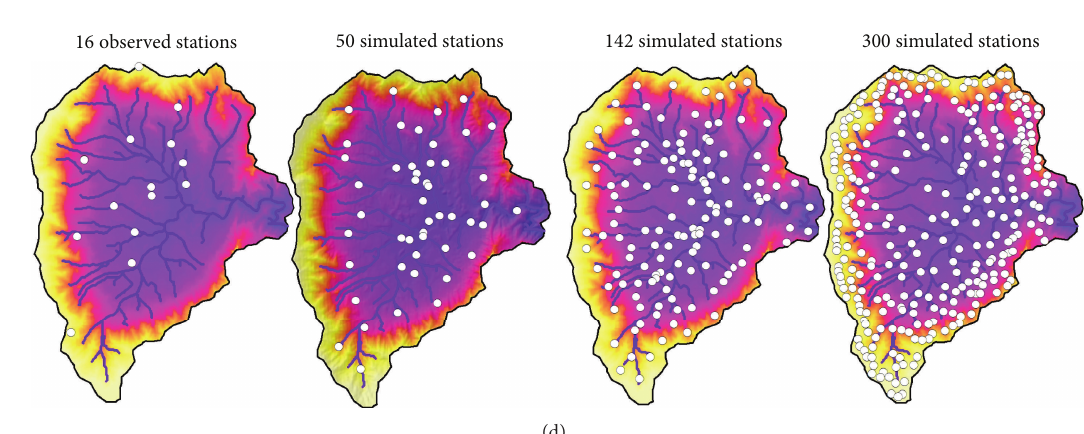
Figure 1: Haean study area location showing (a) observed surface water monitoring locations and meteorological stations, (b) aggregated soil distribution, (c) consolidated land use classification, and (d) meteorological station distribution of 16, 50, 142, and 300 point locations.